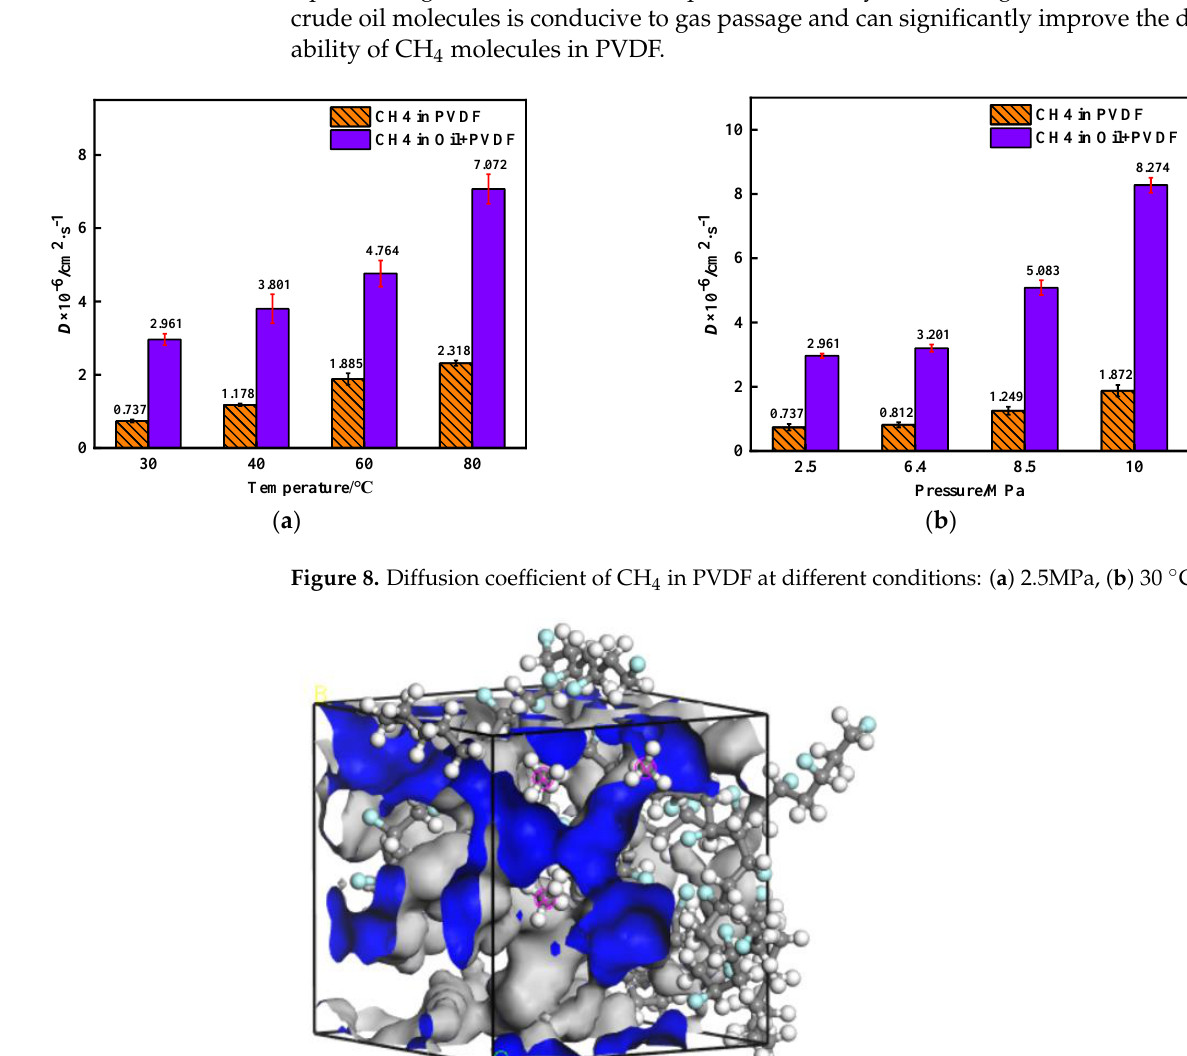
Figure 9. The free volume distribution of CH 4 /(Oil + PVDF) cell.